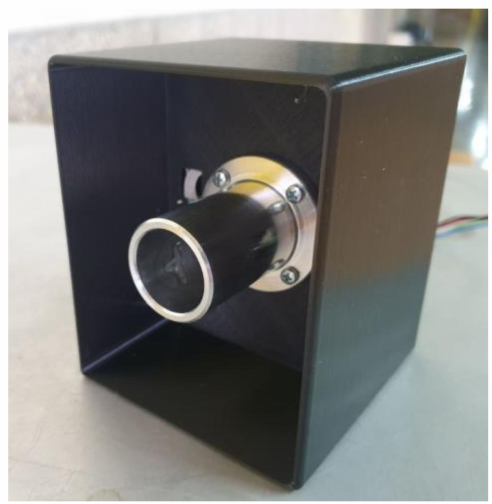
Figure 7. A photo of the radiometer under study.